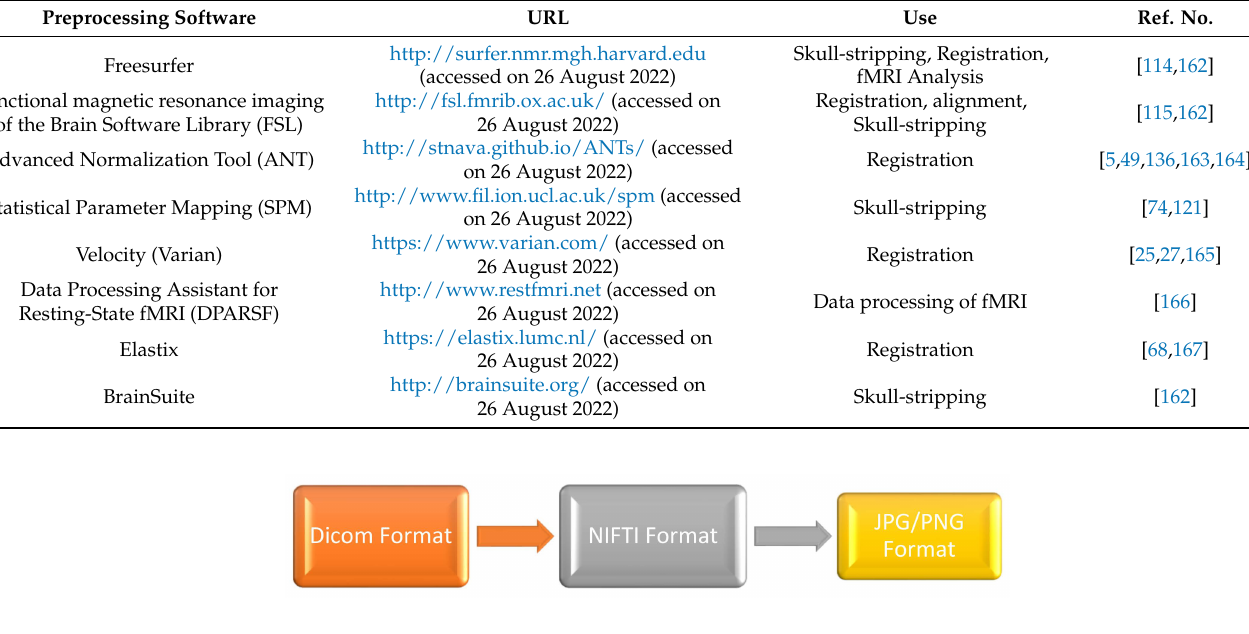
Figure 10. Format conversion of ground truth brain